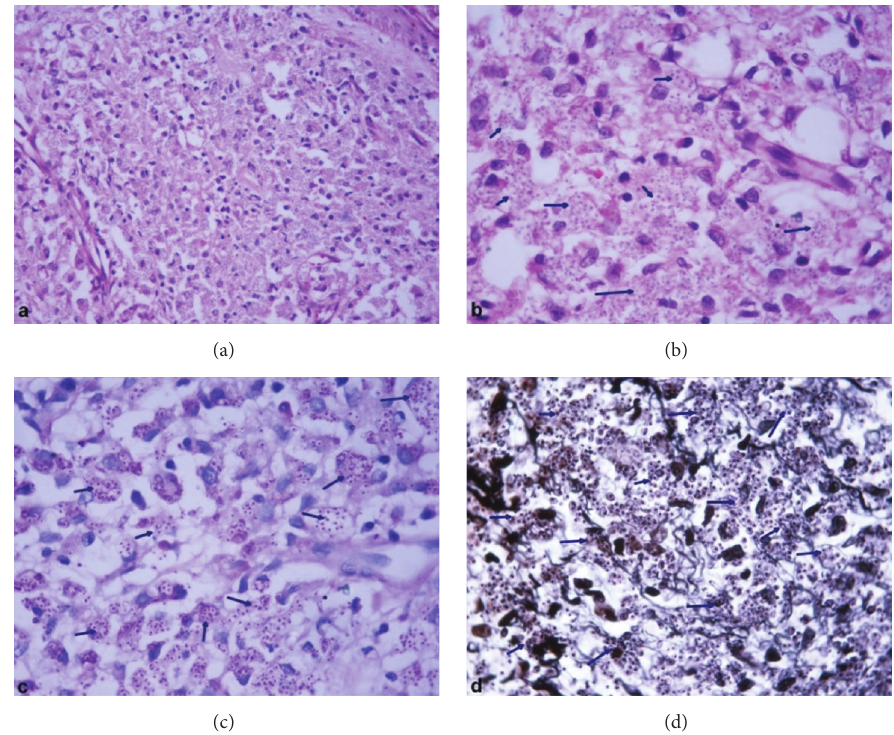
Figure 2: Skin biopsy shows a dense dermal histiocytic infiltrate with the presence of numerous intracellular spherical organisms surrounded by a halo in histiocytes, hematoxylin and eosin (H&E): (a) × 400 and (b) × 1000. These organisms stained positive with periodic acid Schiff (c) × 1000 and silver methenamine (d) × 1000 stains. All are morphologically compatible with Histoplasma as focused with